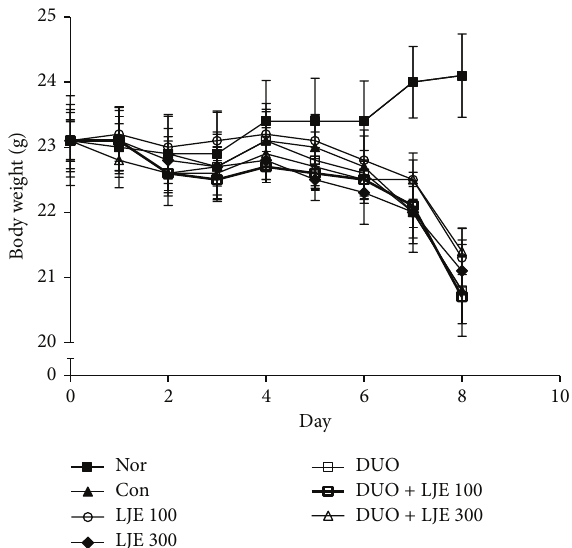
Figure 1: Effects of LJE or DUO on mice weight in DSS-induced colitis. Data are expressed as mean ± S.E.M ( 𝑛 = 7 ). Nor: normal mice without any treatment, Con: mice provided with only 5% DSS treatment, LJE: the water extract of Laminaria japonica , DUO: Duolac7S,LJE+DUO:cotreatmentofLJEandDUO,100:thedosage of LJE 100 mg/kg, and 300: the dosage of LJE 300